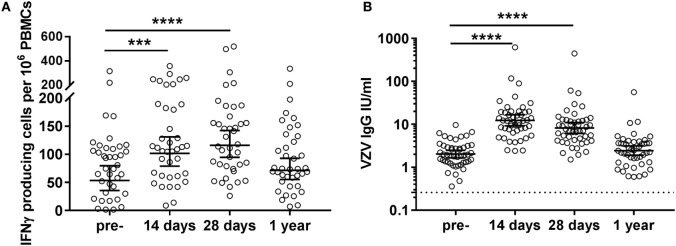
Varicella zoster virus (VZV)-specific cellular and humoral immunity post VZV vaccination in middle-aged adults. (A) VZV-specific IFNγ-producing cell responses per 106 peripheral blood mononuclear cells (PBMCs), as measured by ELISpot, at the different time points pre- and post-vaccination (N = 39) after subtraction of the values in the mock control. The different time points were compared with the Wilcoxon singed rank test preceded by the Friedman test and corrected for multiple comparisons. (B) VZV-specific IgG responses at the different time points pre- and post-vaccination (N = 47). The IgG (IU/mL) concentrations were log-transformed to reach the normality distribution and compared with the ANOVA with correction for multiple testing. The dotted lines indicate the seropositivity thresholds. In all graphs, the geometric mean values with 95% confidence interval are indicated. *p < 0.05, ***p < 0.001, and ****p < 0.0001.